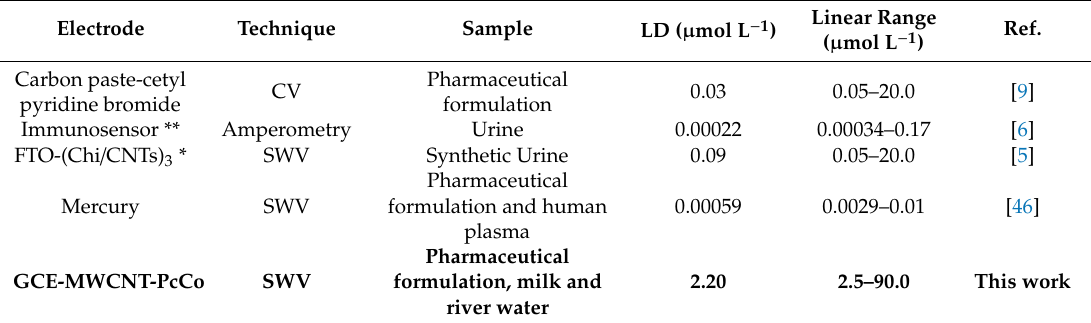
Table 13. Comparative results of di ff erent electroanalytical methods for ethinyl estradiol